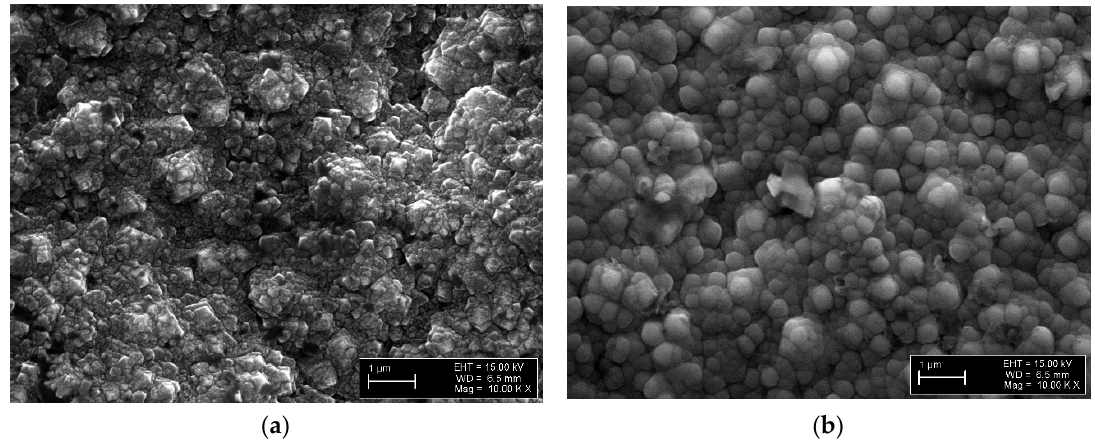
Figure 1. ( a ) SEM images of the NCD and ( b ) Al 2 O 3 /NCD films.